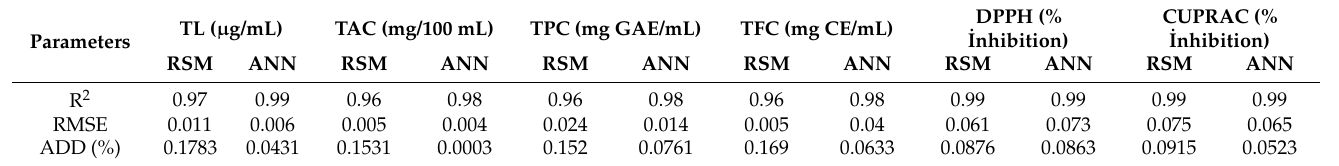
Figure 3. ( A – F ) Optimal architecture of developed ANN model and performance plot for the ANN model. Table 4. Predictive capacity comparison of RSM and ANN models for six response variables.